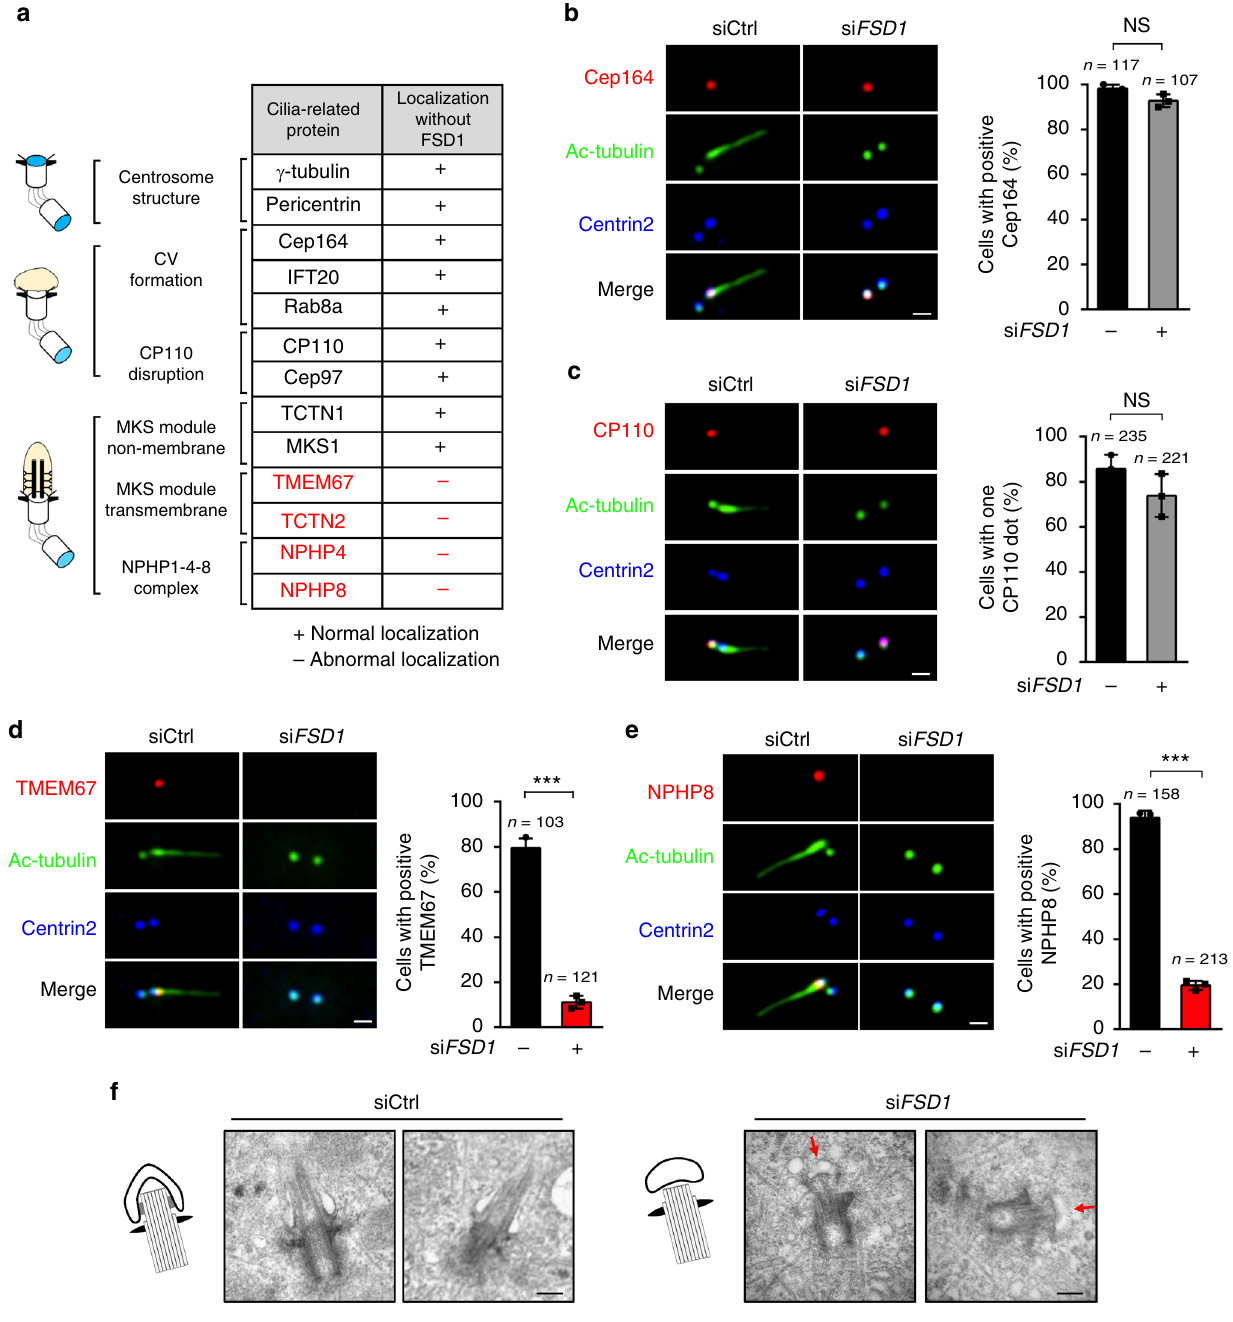
Fig. 2 Loss of FSD1 blocks ciliogenesis at the stage of transition zone assembly. a A table summarizing the centrosome localization of the tested proteins in FSD1-depleted RPE-1 cells. CV ciliary vesicle. b – e RPE-1 cells were treated with control or FSD1 siRNAs followed by serum starvation for 48 h, then subjected to staining with indicated antibodies. Scale bars, 1 μ m. b The Cep164 localization was not affected by FSD1 depletion. c FSD1 depletion did not affect the disruption of CP110 at the mother centriole. d , e Loss of FSD1 affected the localization of TMEM67 and NPHP8. f Depletion of FSD1 caused ciliary transition zone assembly defects. Representative electron micrographs of basal bodies in RPE-1 cells transfected with control (left) or FSD1 (right) siRNA, followed by serum starvation. Arrows indicate small membrane vesicles connected to FSD1-de fi cient centrioles through the distal appendage. Schematic diagrams summarizing the phenotype are shown. Scale bars, 200 nm. Data are presented as mean ± s.d. of three independent experiments. n number of cells. In all panels, statistical comparisons between two groups were carried out by two-tailed t -test. NS not signi fi cant, *** P <